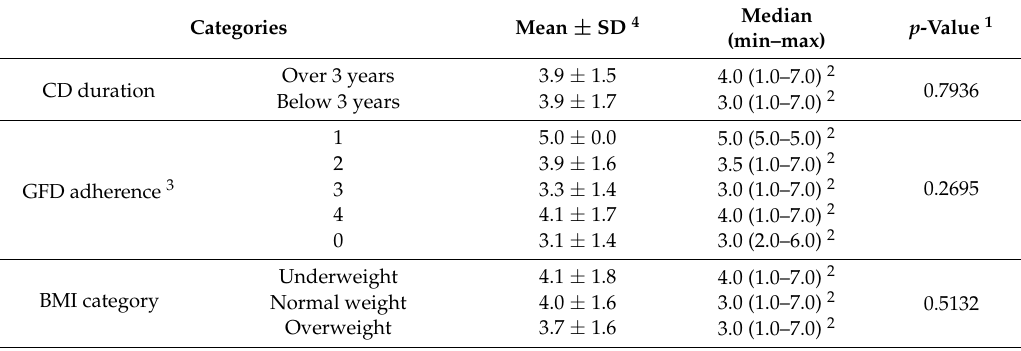
Table 7. Purchase-related emotions and behaviors data regarding question about purchasing GF products because of mood ( In the past 2 weeks, how many times did you buy GF products to improve your mood? ) categorized by CD duration, GFD adherence, BMI and sociodemographic